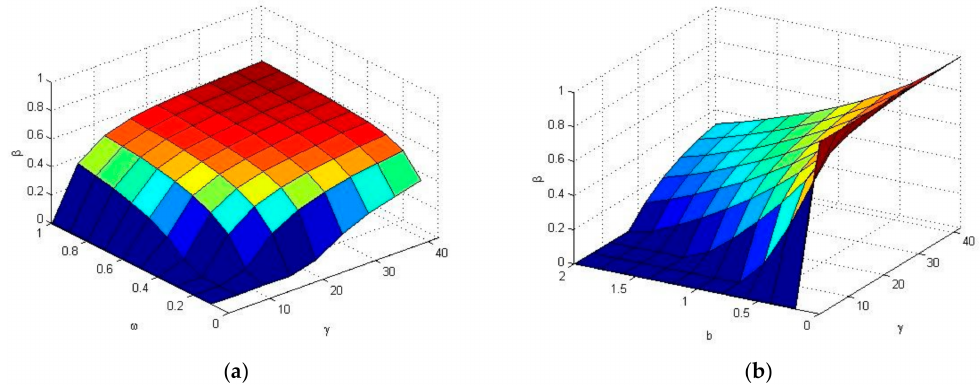
Figure 6. Enterprise’s profit margin and OPPSC with ( a ) different proportions of land increment income in land transfer fee and ( b ) different marginal utility elasticities of the lump-sum currency